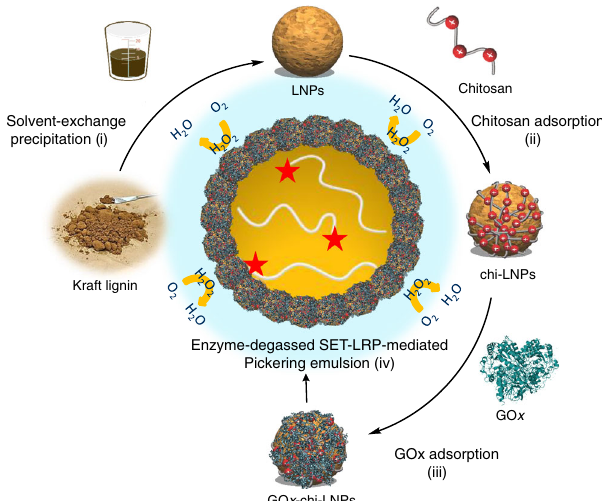
Fig. 1 General process scheme for the preparation of GOx-chi-LNPs via a two-step adsorption immobilization process and application in enzyme- degassed SET-LRP-mediated Pickering emulsion process. (i) Preparation of LNPs via solvent-exchange precipitation. (ii) adsorption of chitosan on LNPs to yield chi-LNPs. (iii) Adsorption of GOx on chi-LNPs to yield GOx- chi-LNPs. (iv) Application of GOx-chi-LNPs as biocatalytic degassing stabilizers for SET-LRP in Pickering emulsion